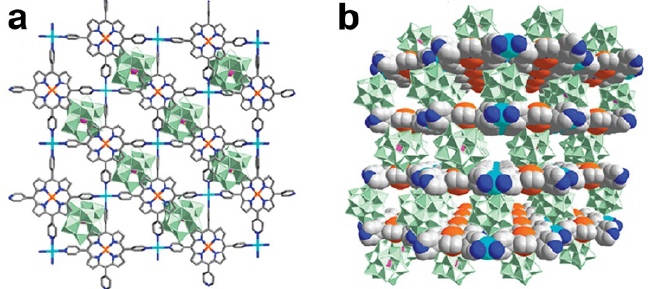
Figure 11. ( a ) Arrangement of a single layer of [Cd(DMF) 2 Mn III (DMF) 2 TPyP] n 3 n +